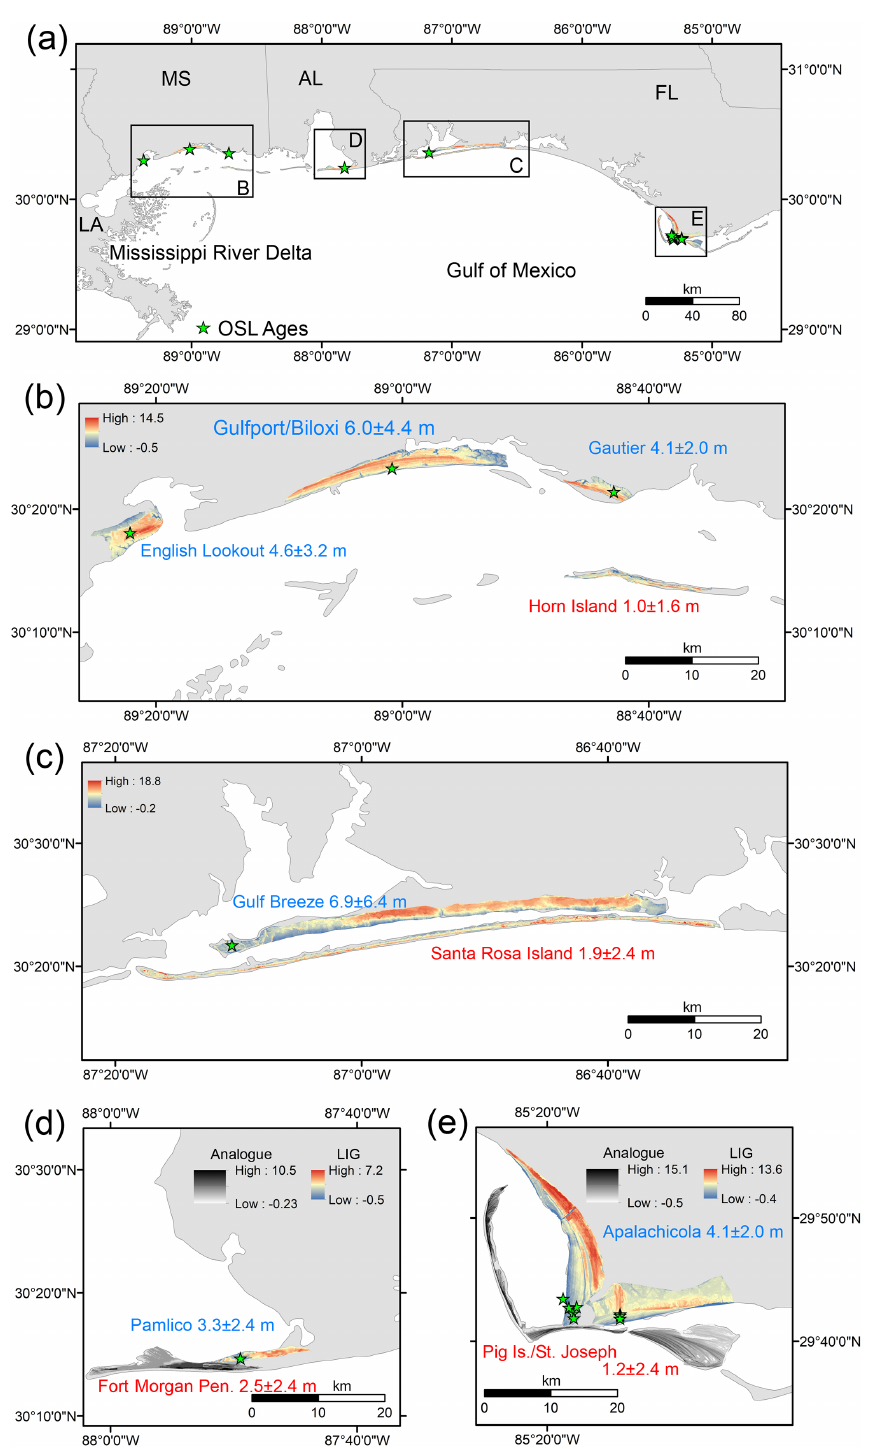
Figure 5. (a) Map of the LIG Gulfport shoreline across the northeastern Gulf of Mexico. Digital elevation models (DEM) of the LIG Gulfport shoreline segments dated along the Mississippi (b) , western Florida Panhandle (c) , Alabama (d) , and Apalachicola delta (e) regions. Stars mark the locations of optically stimulated luminescence ages. The LIG shoreline segment names and average elevations are given in blue text, while the modern barrier island names and average elevations are given in red